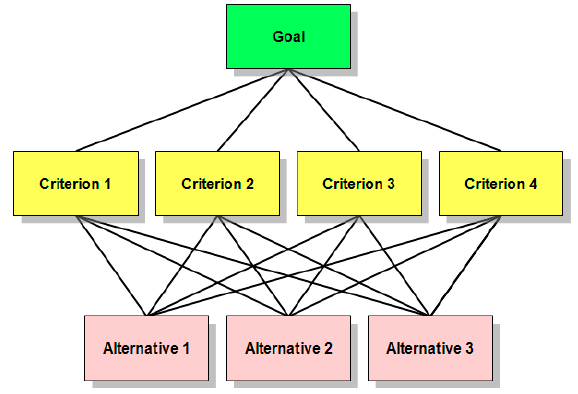
Figure 4. Flow chart of the Analytic Hierarchy Process (AHP) methodology.